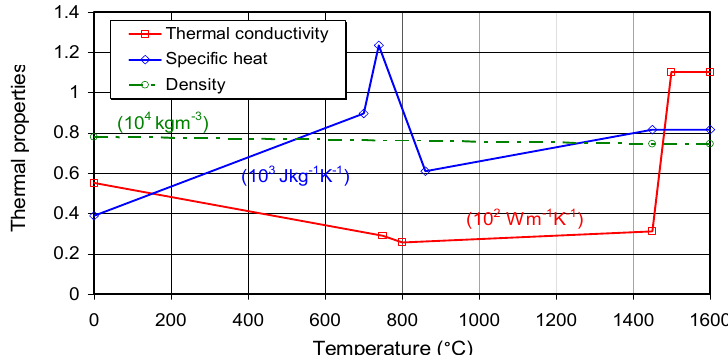
Figure 3. X-ray residual stress measurement.